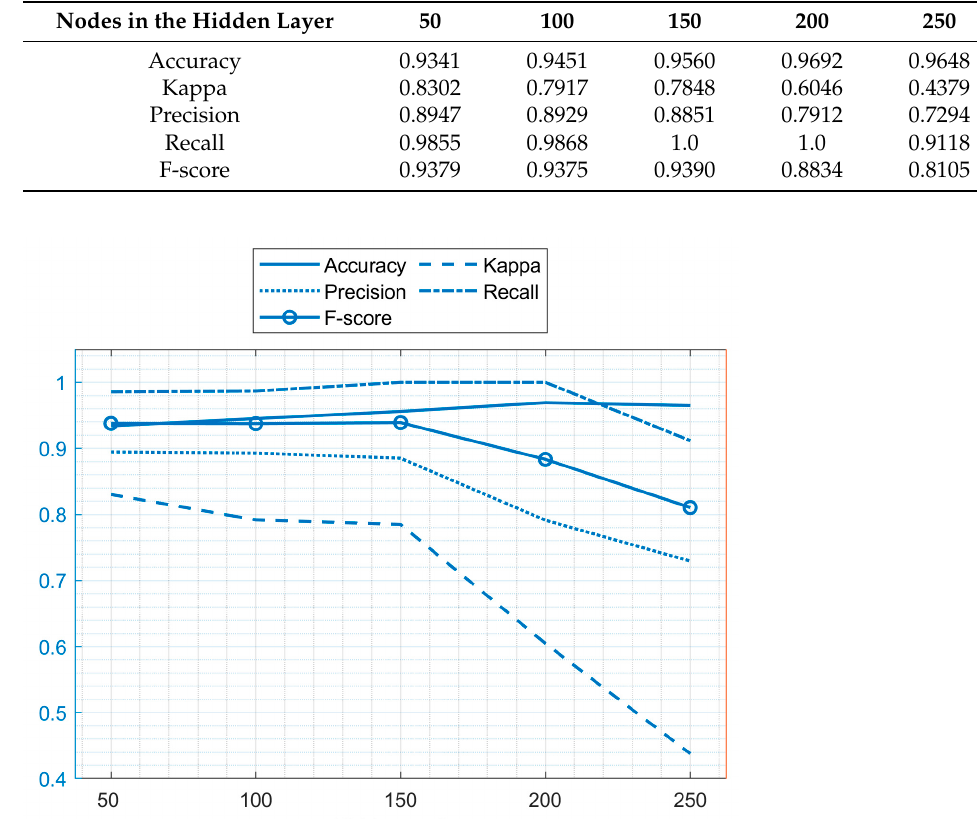
Table 6. Performance of different machine learning models deployed in a standalone environ-